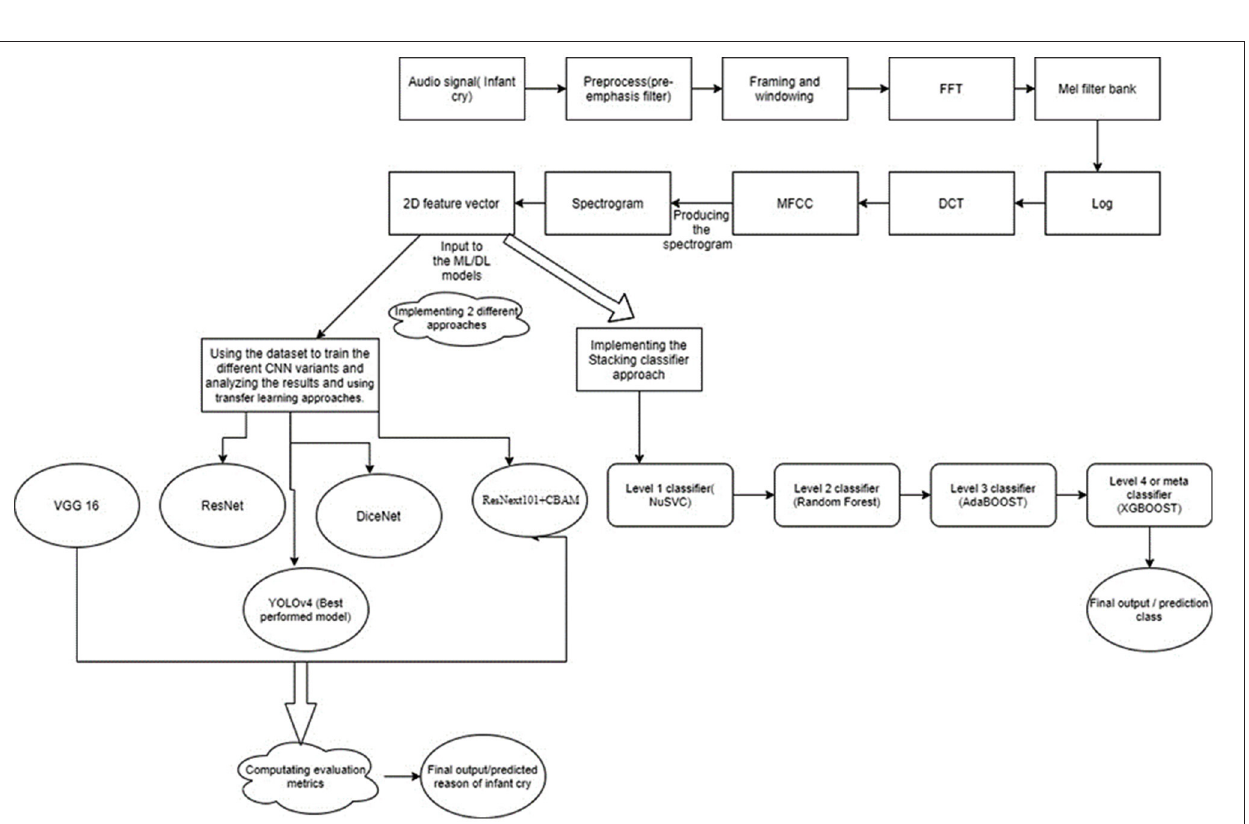
FIGURE 4 | Workflow of the research techniques used in this work.